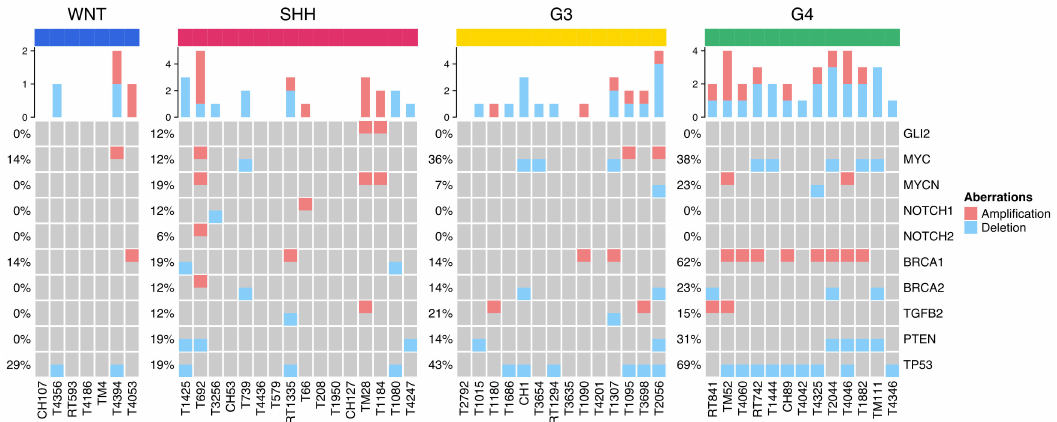
Figure 3. Subgroup distribution of gene CNVs of 50 MBs with DNA methylation analysis split into blue (loss) and red